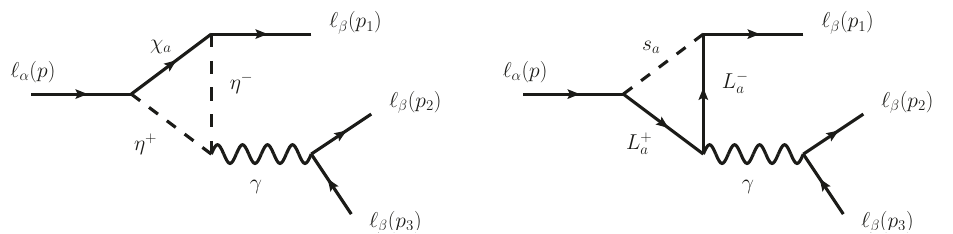
decay. The index a reads 0 , 1 → ‘ − ‘ − ‘ + α β β β = η 0 , s = S for the charged lepton loops. The 1 2